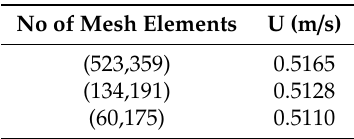
Table 2. Mesh independence test ( reactor